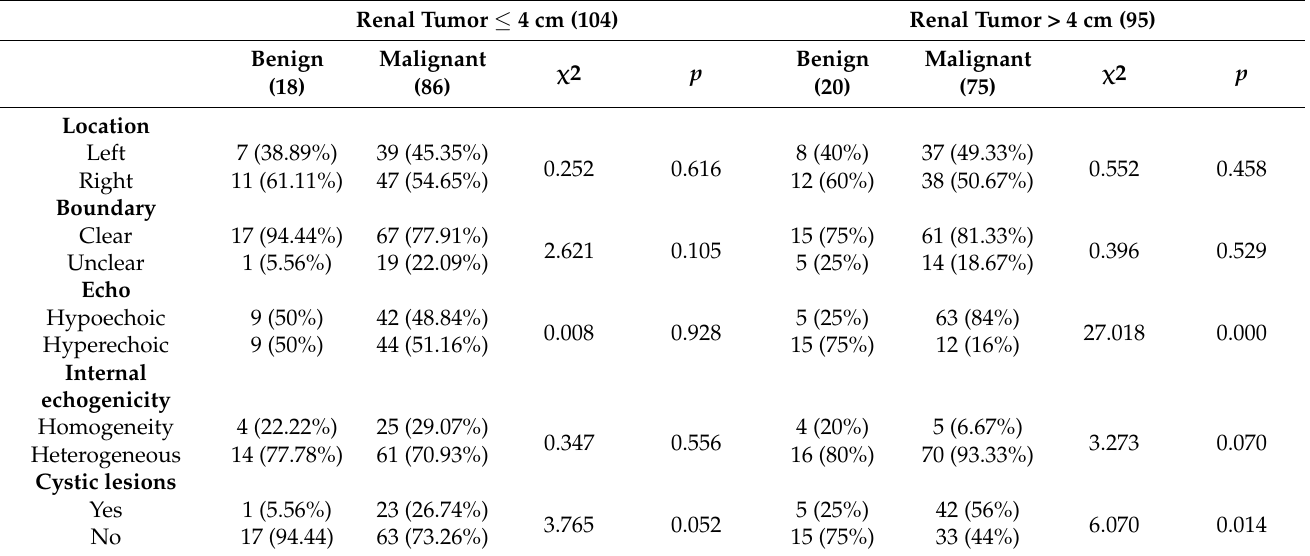
Table 2. Grayscale ultrasonic features of benign and malignant renal tumors in two Groups (n).